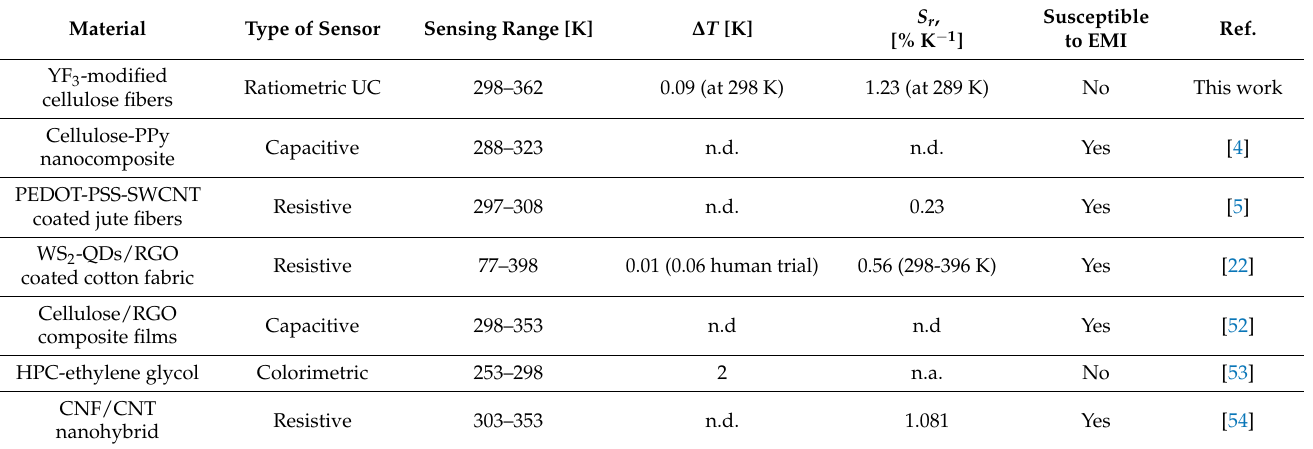
Table 2 . Comparison of the cellulose-based temperature sensors reported in the literature with the YF 3 -modified cellulose fibers shown in this work.